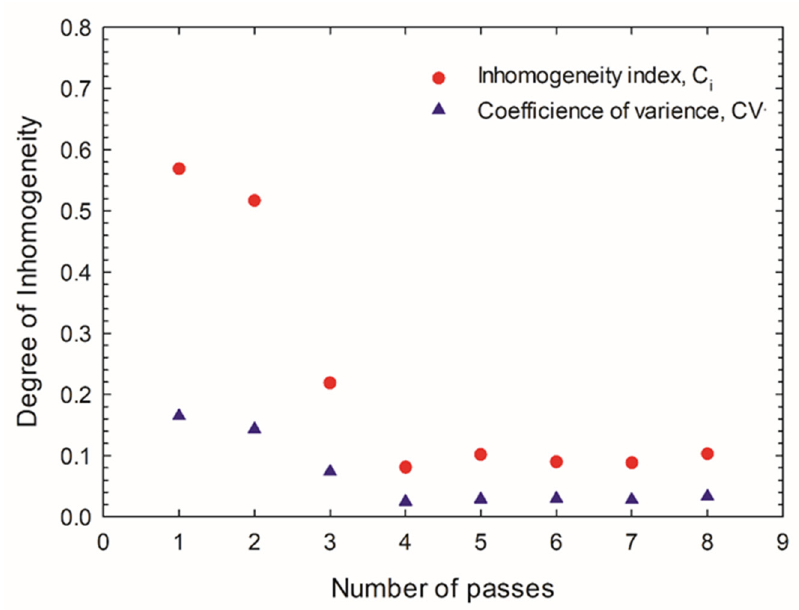
Figure 8. Inhomogeneity in equivalent plastic strain indicated by the inhomogeneity index and by the coefficient of variance.